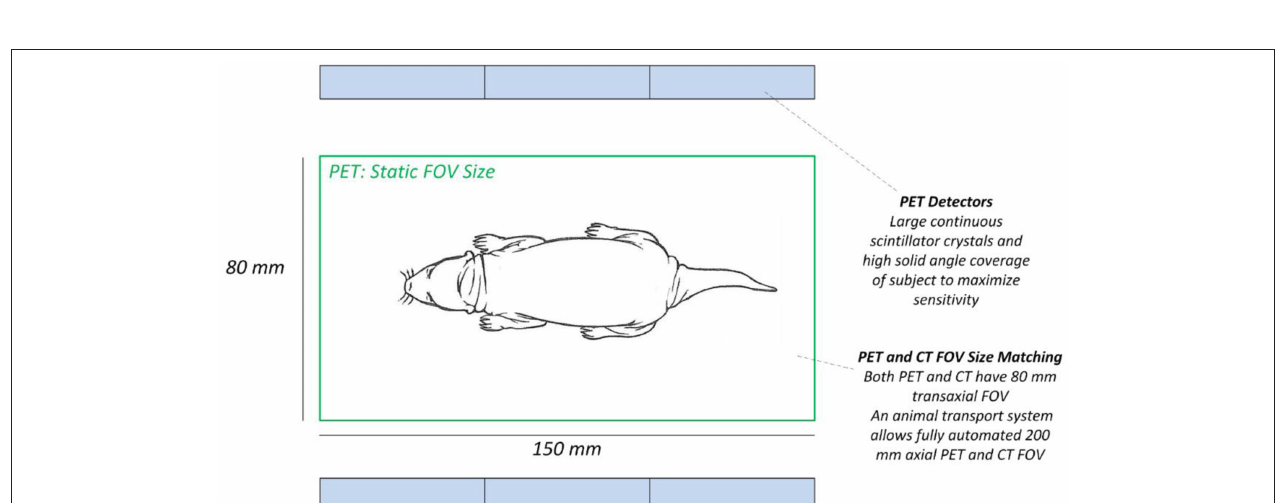
FIGURE 1 | The new PET/CT “Si78”.